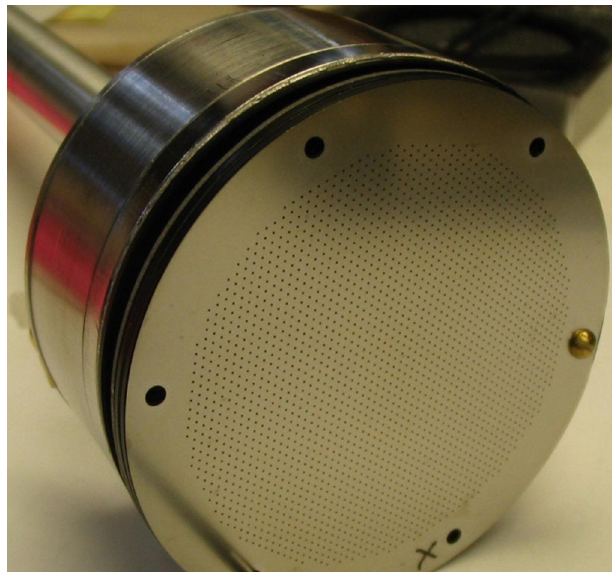
FIG. 4. (Color) Photograph of the pinhole Faraday cup diagnos- tic before installation on NDCX-1A.